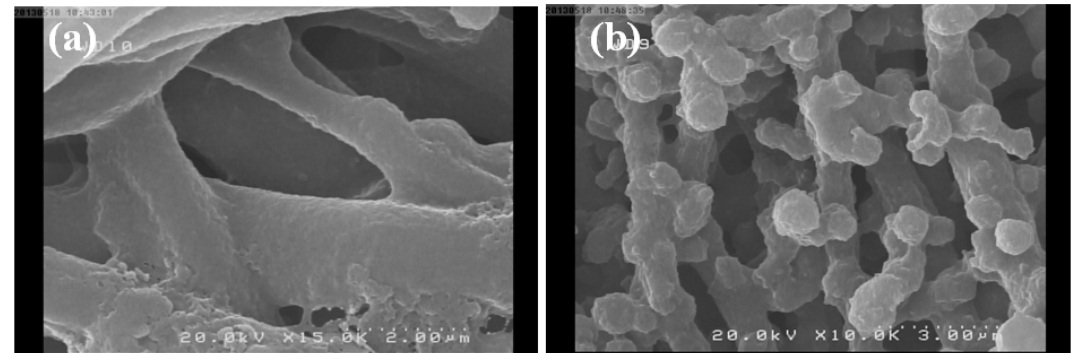
Fig. 1: FESEM images of ESM (A) and GQDs doped ESM (B)